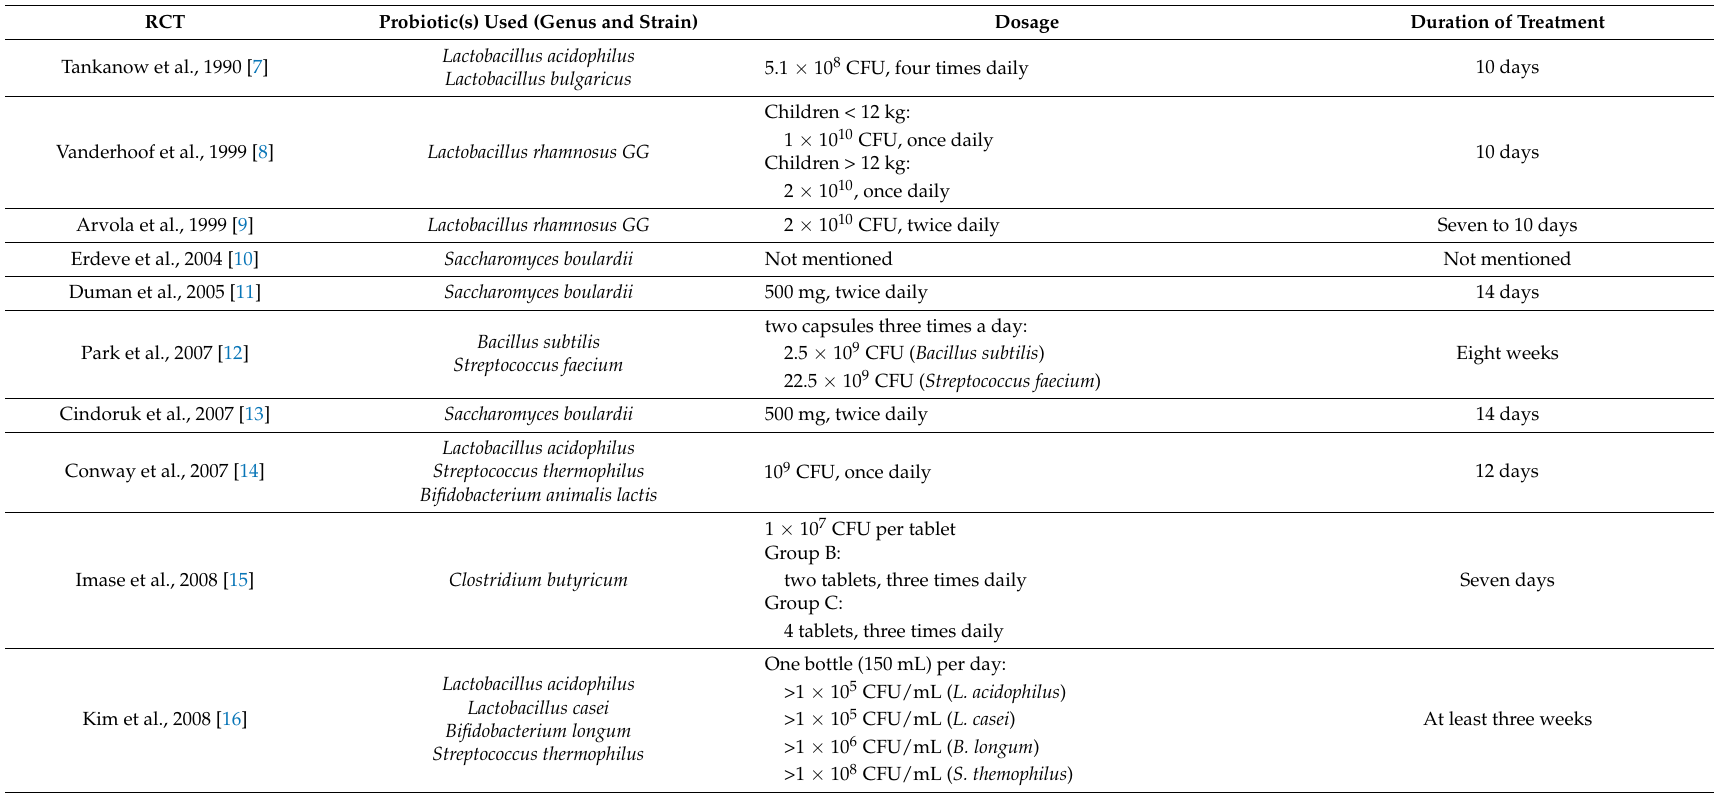
Table 1. Probiotic(s) used, dosages, and treatment